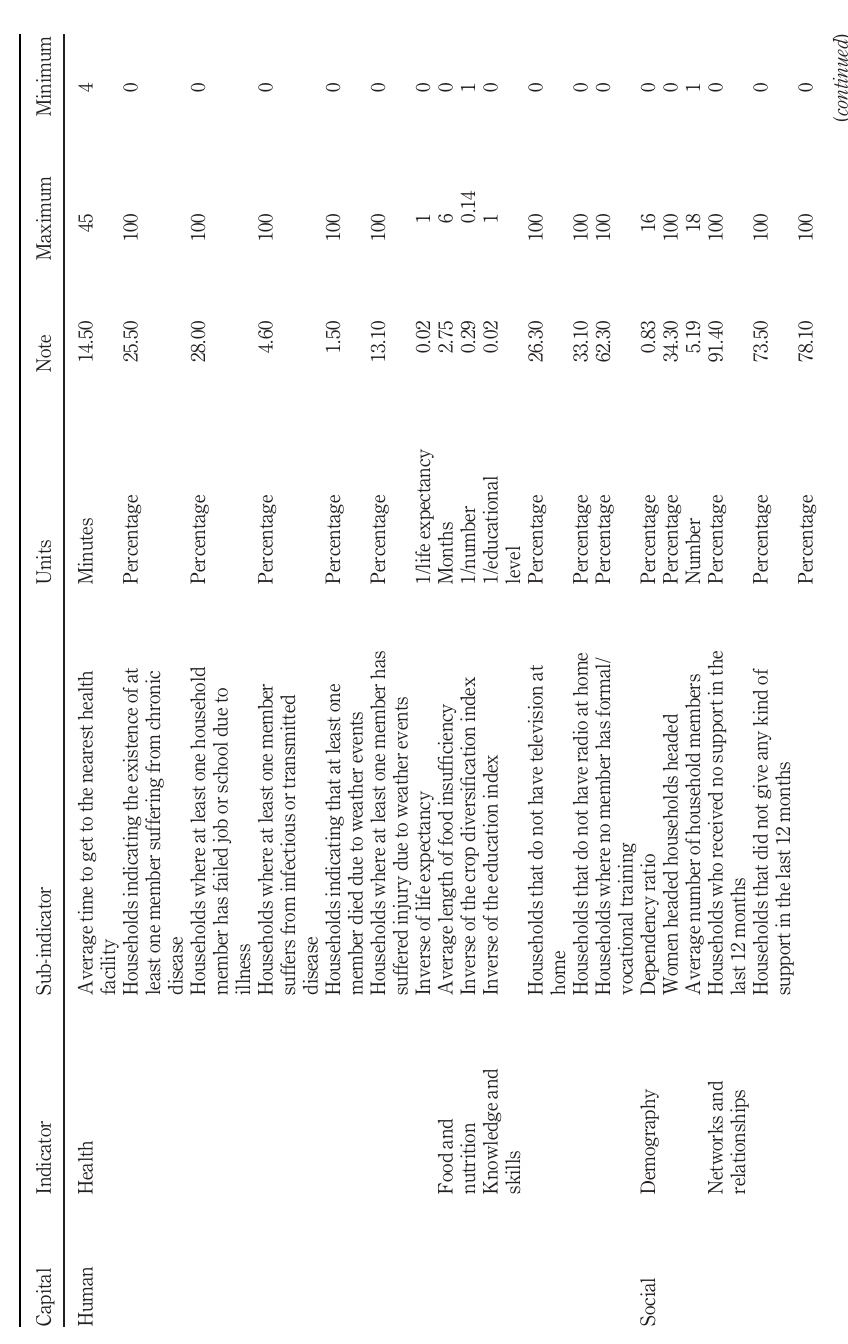
Table III. Statistical data on the indicators and sub-indicators used in the